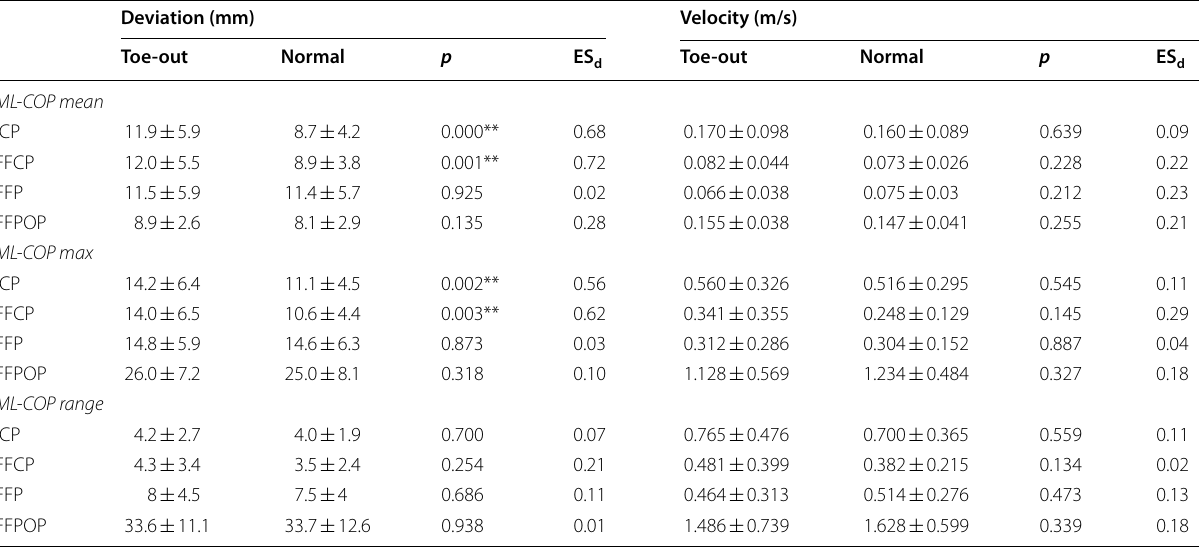
Values are expressed as mean standard deviation ML-COP: COP in medial–lateral ±